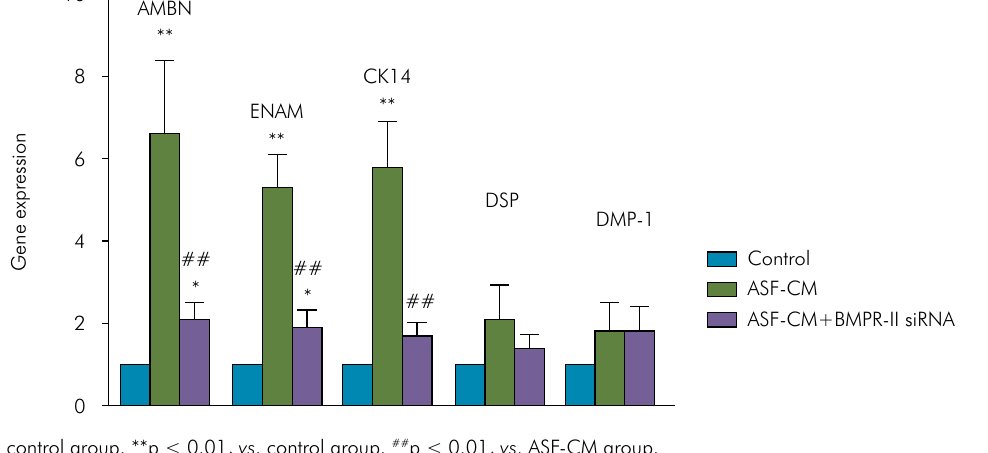
Figure 2. RT-PCR analysis of the expression of ameloblast-specific genes ( Ambn , ENAM , and Ck14) and odontoblast-specific genes ( Dmp-1 and Dsp ) in iPS cells induced by the control medium, ASF-CM, or ASF-CM+BMPR-II siRNA.